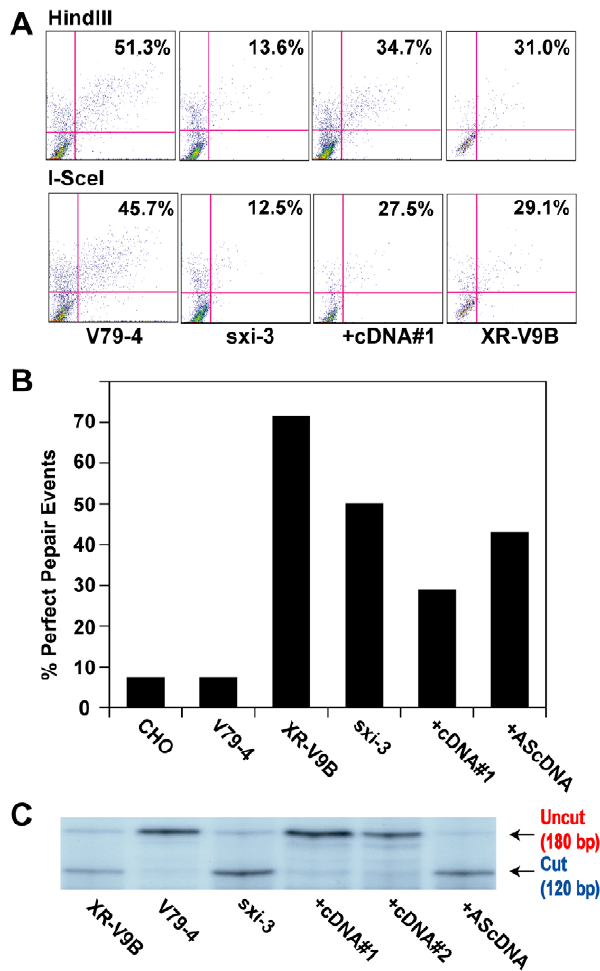
Figure 8. Microhomology-mediated end joining in hamster Ku86-null cell lines. (A) The indicated cell lines were transfected with HindIII - (Top panels) or I-SceI -(Bottom panels) linearized pEGFP-Pem1- Ad2 together with a supercoiled pCherry plasmid (to monitor transfection efficiency). The number in the top right corner corresponds to the percentage of cells that turned green after 24 hr as a percentage of the cells productively transfected. + cDNA # 1 corresponds to a sxi-3 cell line that has been stably complemented with a Ku86 cDNA. (B) HindIII -linearized pEGFP-Pem1-Ad2 plasmids were recovered from the indicated cell lines, propagated through E. coli and then analyzed for retention of a single HindIII restriction site (‘‘perfect rejoining’’) by HindIII restriction enzyme digestion analysis. (C) The indicated cell lines were transfected with the pDVG94 plasmid that had been linearized by Eco47III and EcoRV digestion. After 24 hr, the plasmids were recovered and then analyzed by PCR as described in Figure 7.